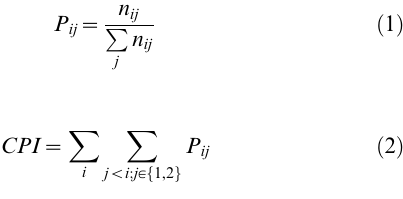
Table 2. Summary statistics on fires obtained from ICS-209 data, sorted according to Forest Service Region, including the proportion of active days (P(j)) in which a given incident was a given complexity level j (exclusive of containment).